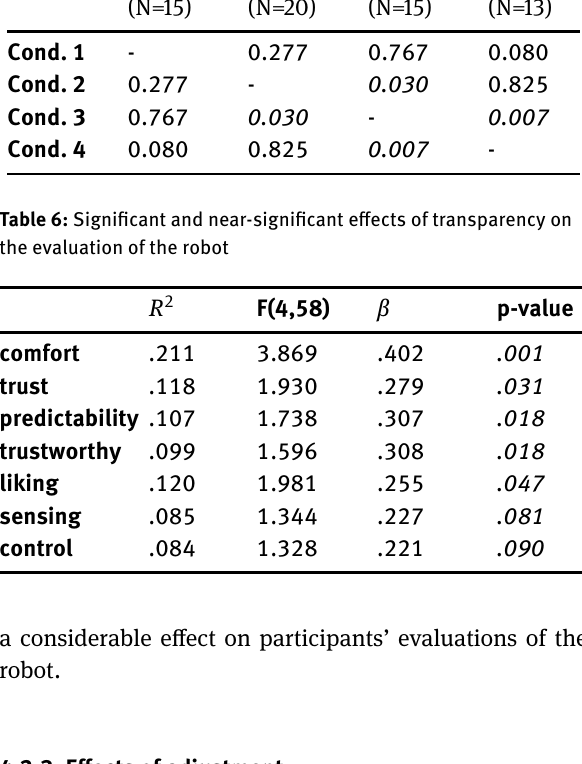
SD=0.913) than in condition 1 (M=4.8, SD=1.474) (t = -2.626; p = 0.035). No other factors apart from trust and comfort